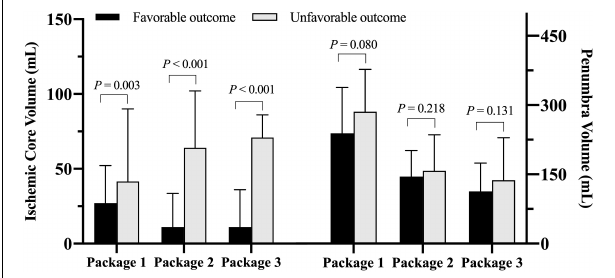
FIGURE 3 | Comparison of ischemic core volume and penumbra volume measured by three software packages between patients with favorable and unfavorable clinical outcomes after endovascular thrombectomy (EVT) (Package 1: ISP; Package 2: RAPID; Package 3: F-STROKE).